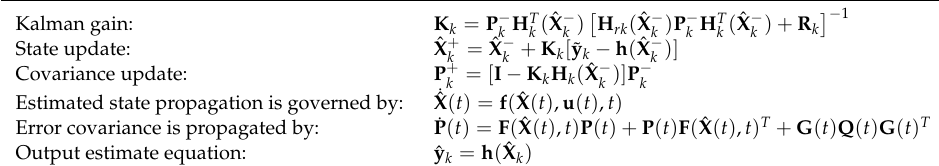
Table 1. Extended Kalman filter (EKF)